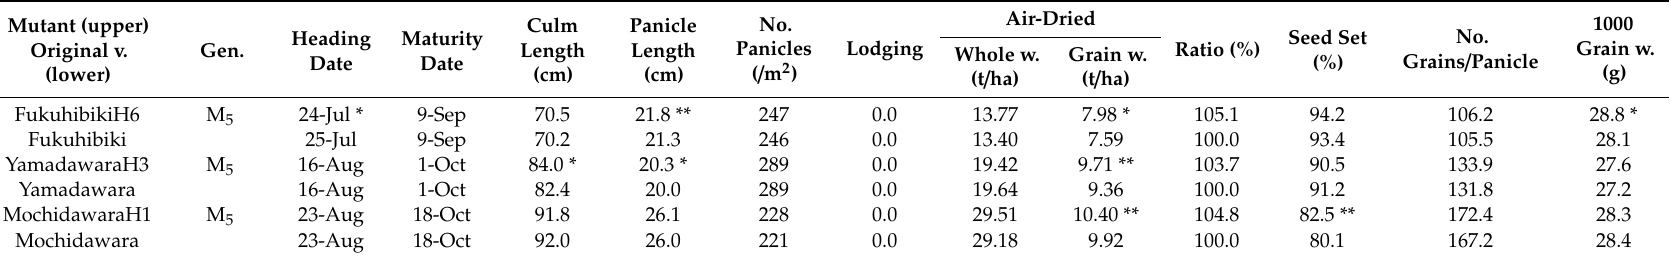
Table 2. Yield trial of mutants in paddy fields in Ibaraki, Japan in 2017.